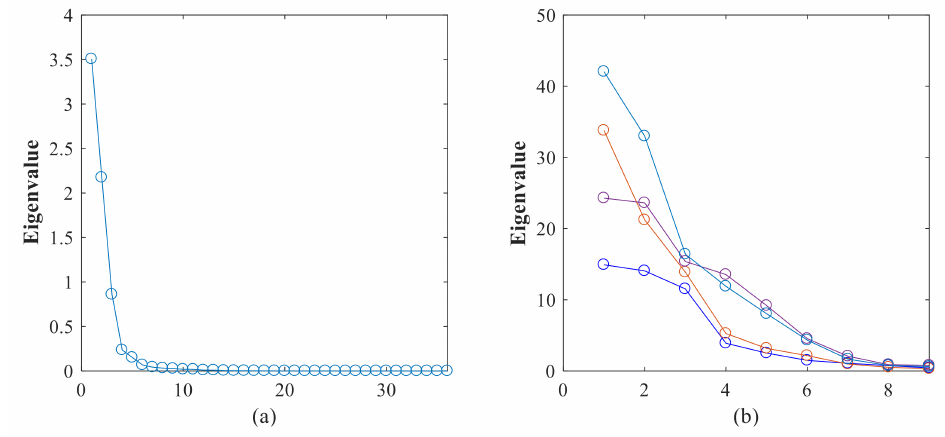
Figure 13. ( a ) Eigenvalues obtained by HOSVD; ( b ) Four sets of eigenvalues obtained by SVD.